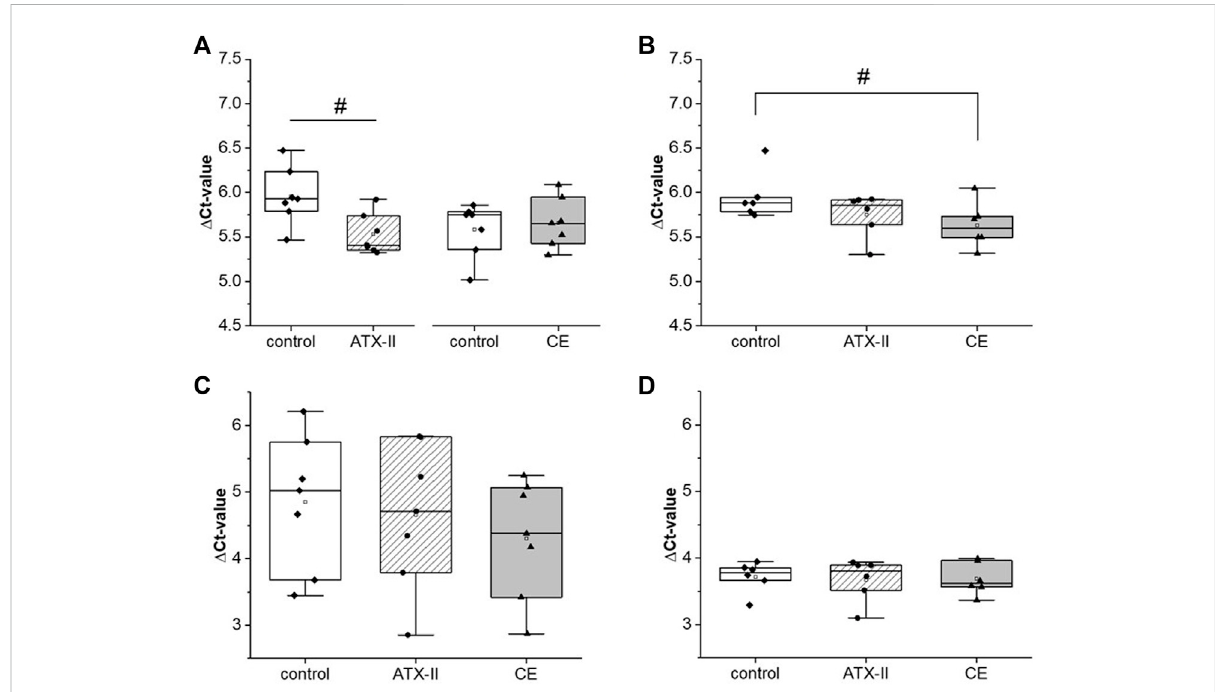
FIGURE 5 The transcription of Rnf8 in colon (A,B) or liver (C,D) tissue of rats 3 h (A,C) or 24 h (B,D) after oral uptake of either the single mycotoxin altertoxinII(ATX-II)oracomplexextract(CE)ofacultured Alternariaalternata strain.Graphsshow Δ CTvaluesasobtainedwithqRT-PCRasboxplots including single results (7 rats per group) of treated animals incomparison to the control group. After con fi rming normal distributionby theShapiro- Wilk test, signi fi cant differences to the respective control group were calculated by one-way ANOVA, followed by Bonferroni post-hoc testing, and are indicated with “ # ” ( p <